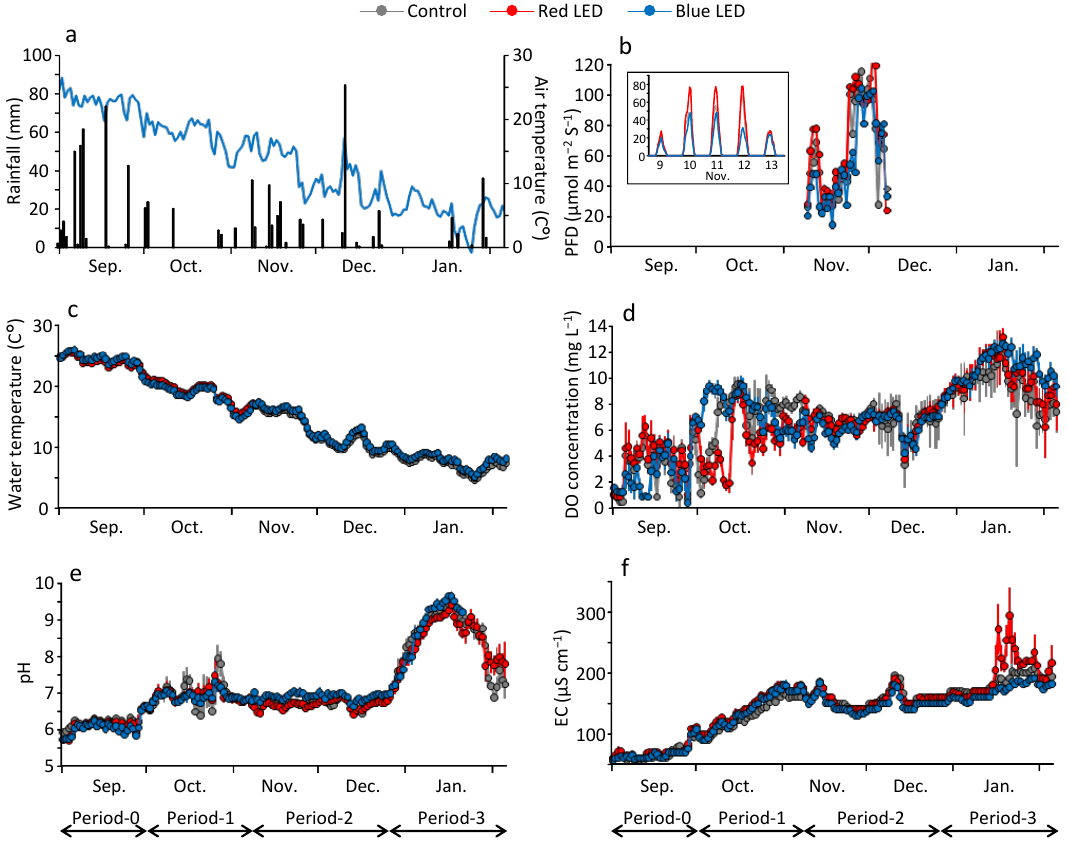
Figure 2. Changes in rainfall, mean air temperature ( a ), photon flux density ( b ), water temperature ( c ), DO concentration ( d ), pH ( e ), and EC ( f ) of the 3 depressions in ponds during the experiment. Daily maximum (with example diel cycle in a small frame) ( b ) and daily mean (±1SD) ( c – f ) are shown. According to the low and fluctuating DO and a constantly low pH and EC, it